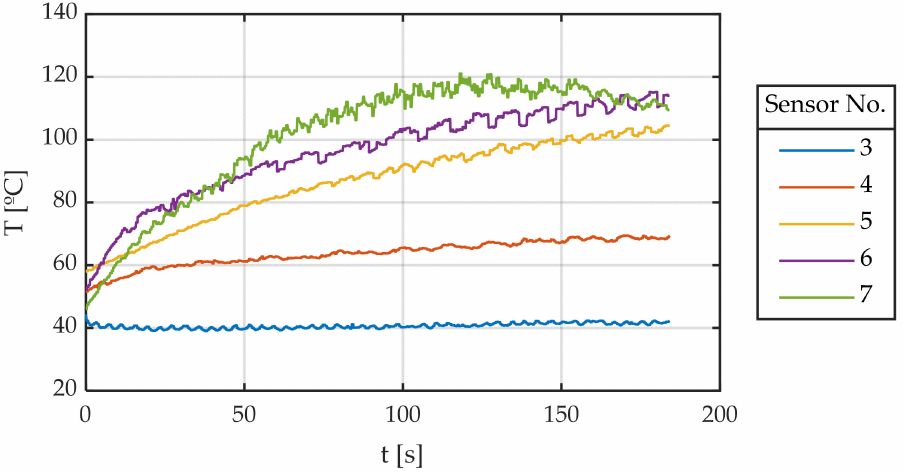
Figure 14. Tread temperatures against time.